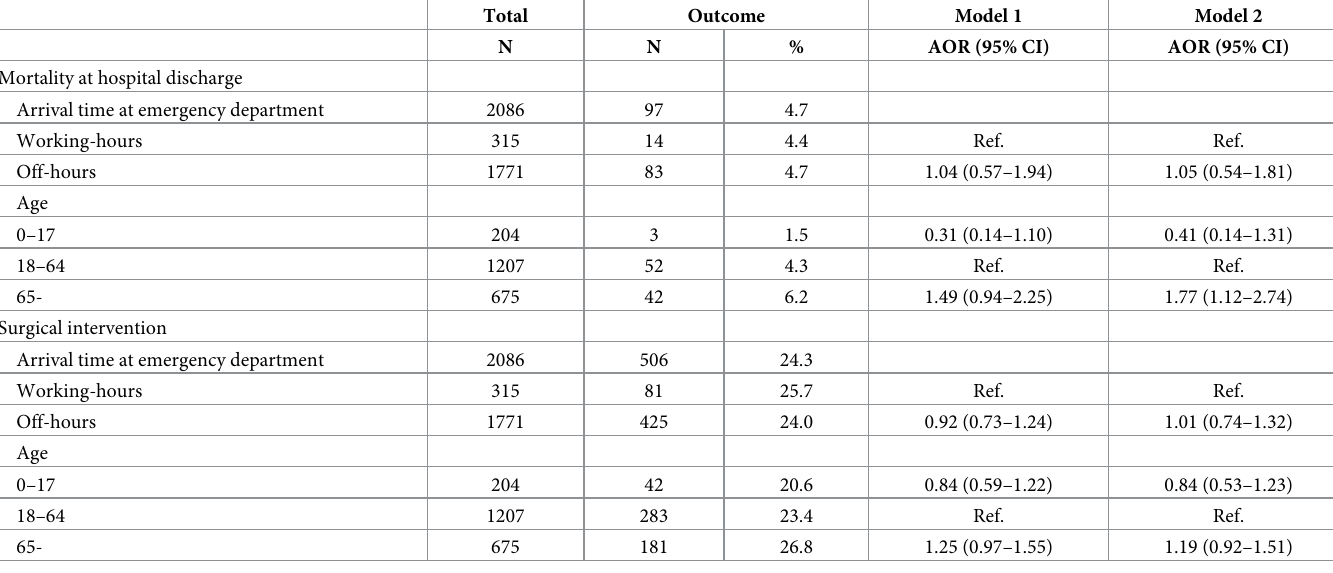
Table 3. Multivariable logistic regression analysis on study outcomes by the arrival time at emergency department.